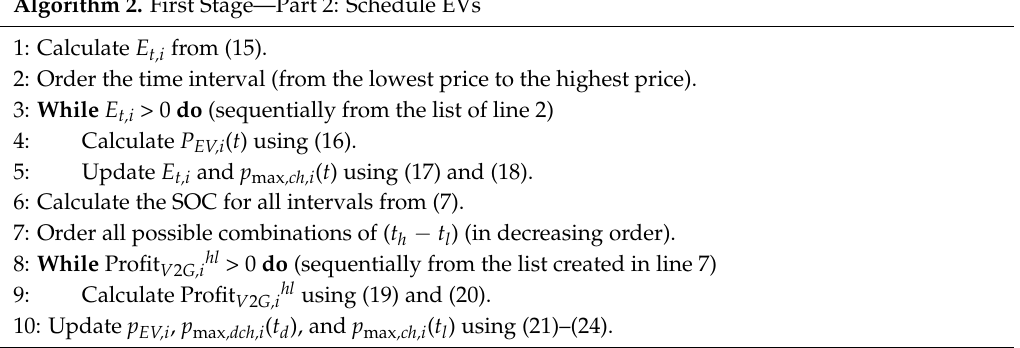
Algorithm 2. First Stage—Part 2: Schedule EVs